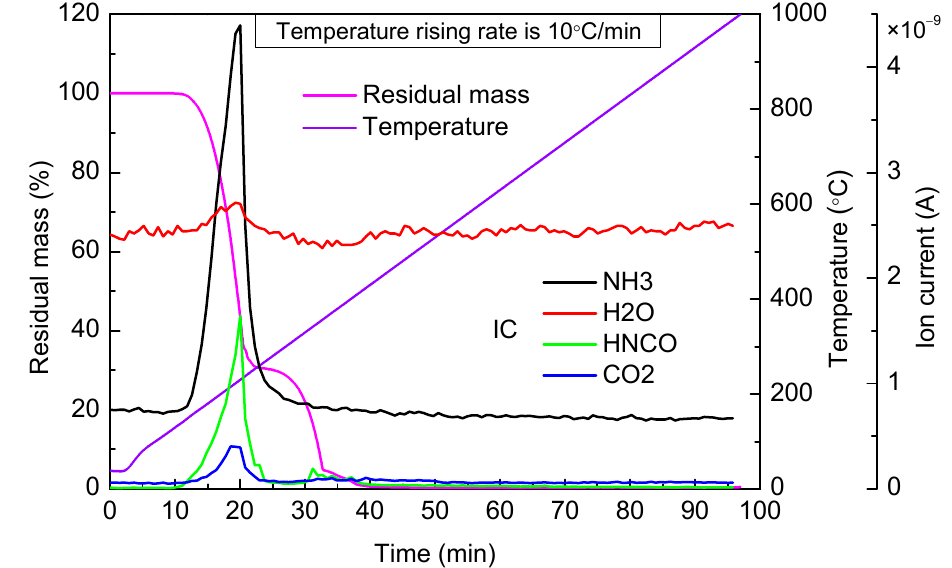
Figure 1. TG-MS results of urea in temperature-rising experiment.